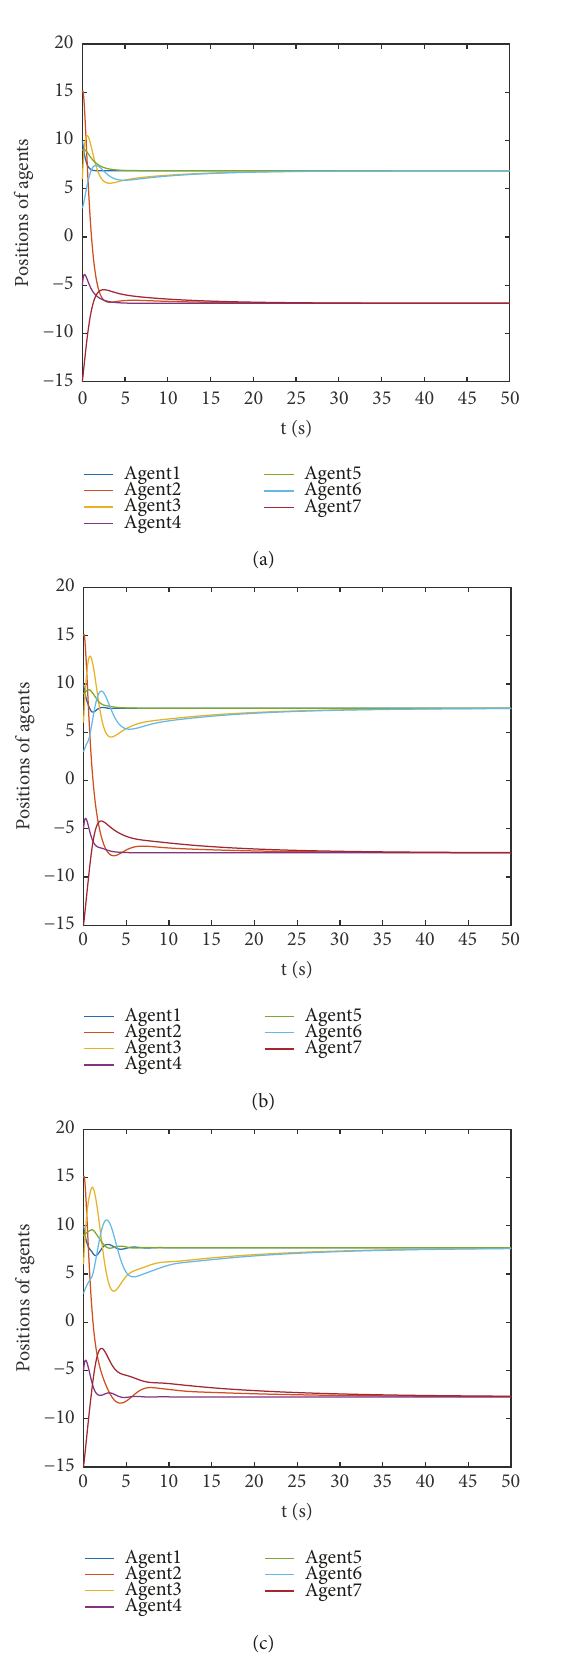
Figure 7: The agents position trajectories, where 𝜏 = 0.05 . (a) 𝜏 𝑖𝑗 = 0 , (b) 𝜏 = 0.5 , and (c) 𝜏 = 0.9 . 𝑖𝑗 𝑖𝑗